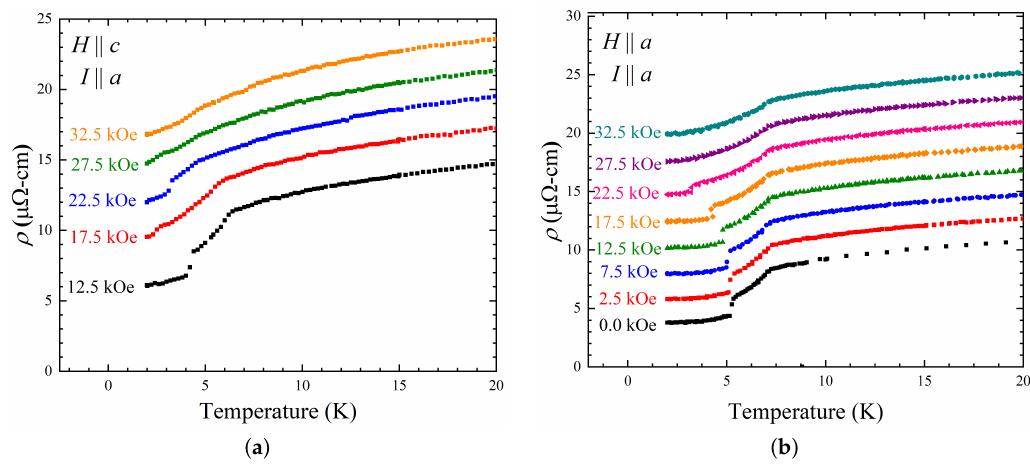
Figure 9. Temperature dependent AC resistivity measurements for HoB 4 for ( a ) H (cid:107) c and ( b ) H ⊥ c in magnetic fields up to 32.5 kOe. Each curve is offset by 2 µ Ω